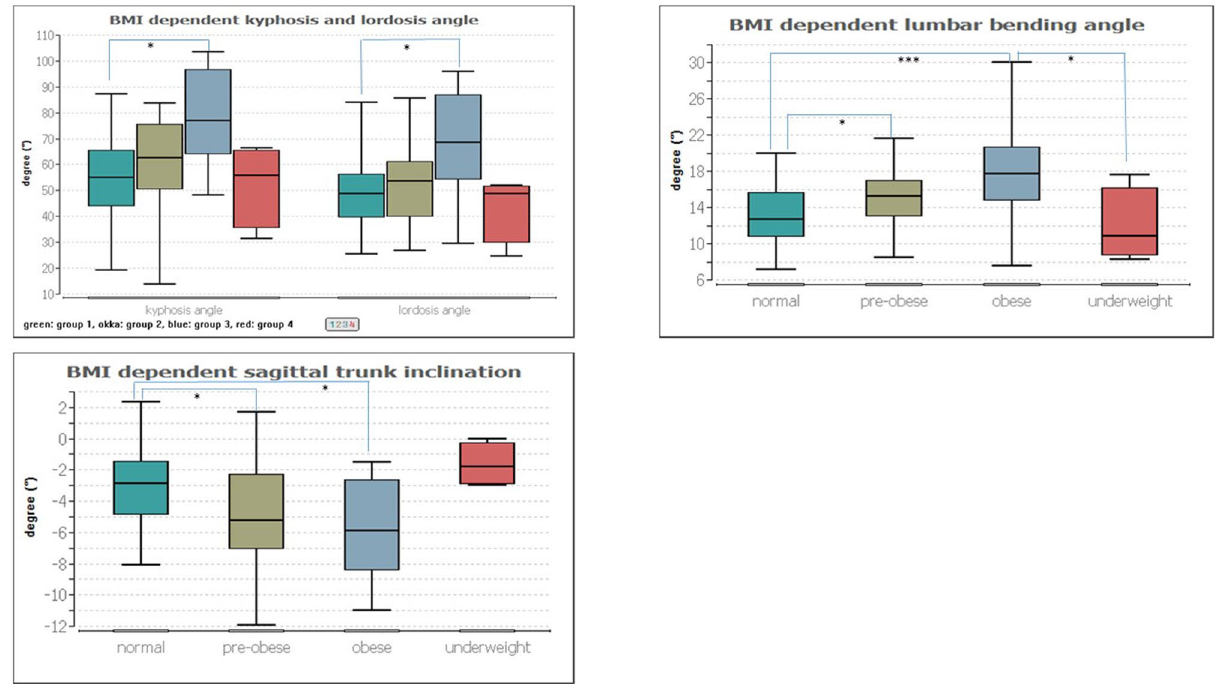
Figure 2. Representation of dependencies between the BMI groups and the kyphosis and lordosis angle (top left), the lumbar flexion angle (top right) and the sagittal trunk inclination. Significant group differences are marked with asterisks, where. * = 0.05, *** =